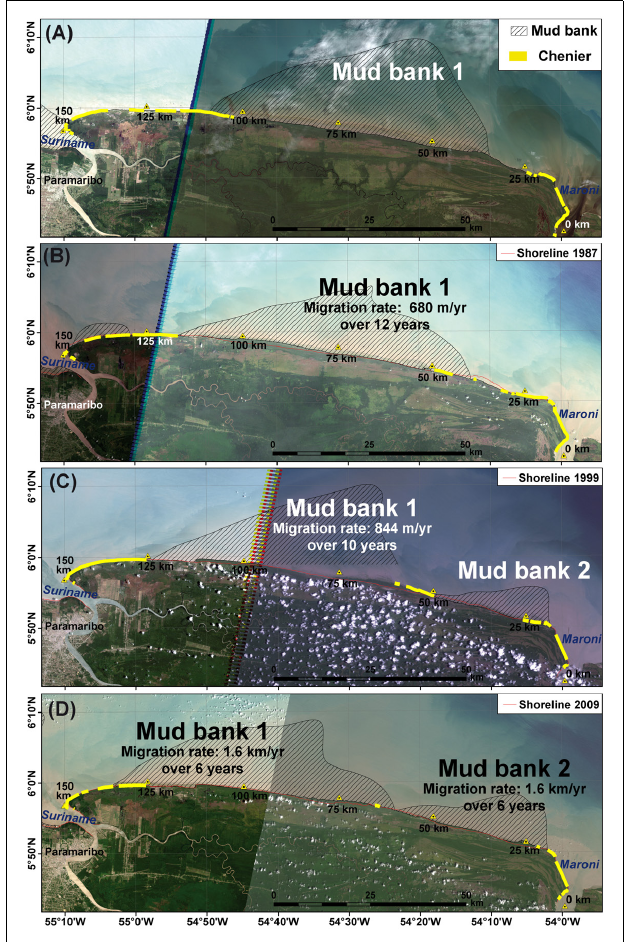
FIGURE 4 | Landsat images of analyzed shoreline changes between the Maroni and the Suriname Rivers (October 1987 to October 2015) showing the impact alongshore of migrating mud banks (muddy shoreline accretion) and inter-bank areas (shoreline erosion characterized by the landward-migrating Braamspunt chenier): (A) situation in 1987; (B) situation in 1999 with the 1987 shoreline; (C) situation in 2009 with the 1999 shoreline; (D) situation in 2015 with the 2009